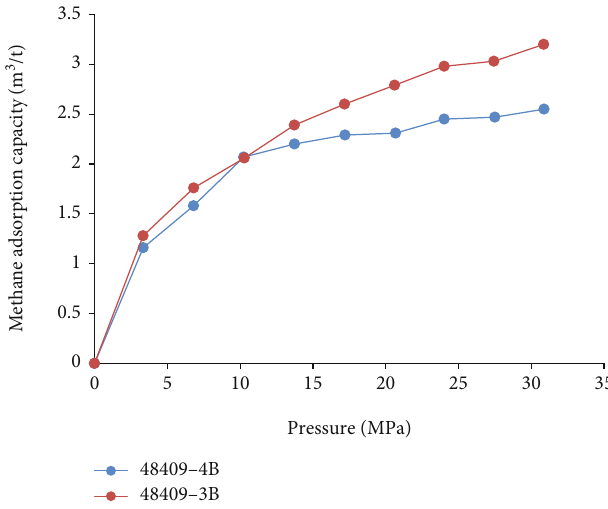
Figure 5: Isothermal adsorption curve for the Longmaxi Formation in well